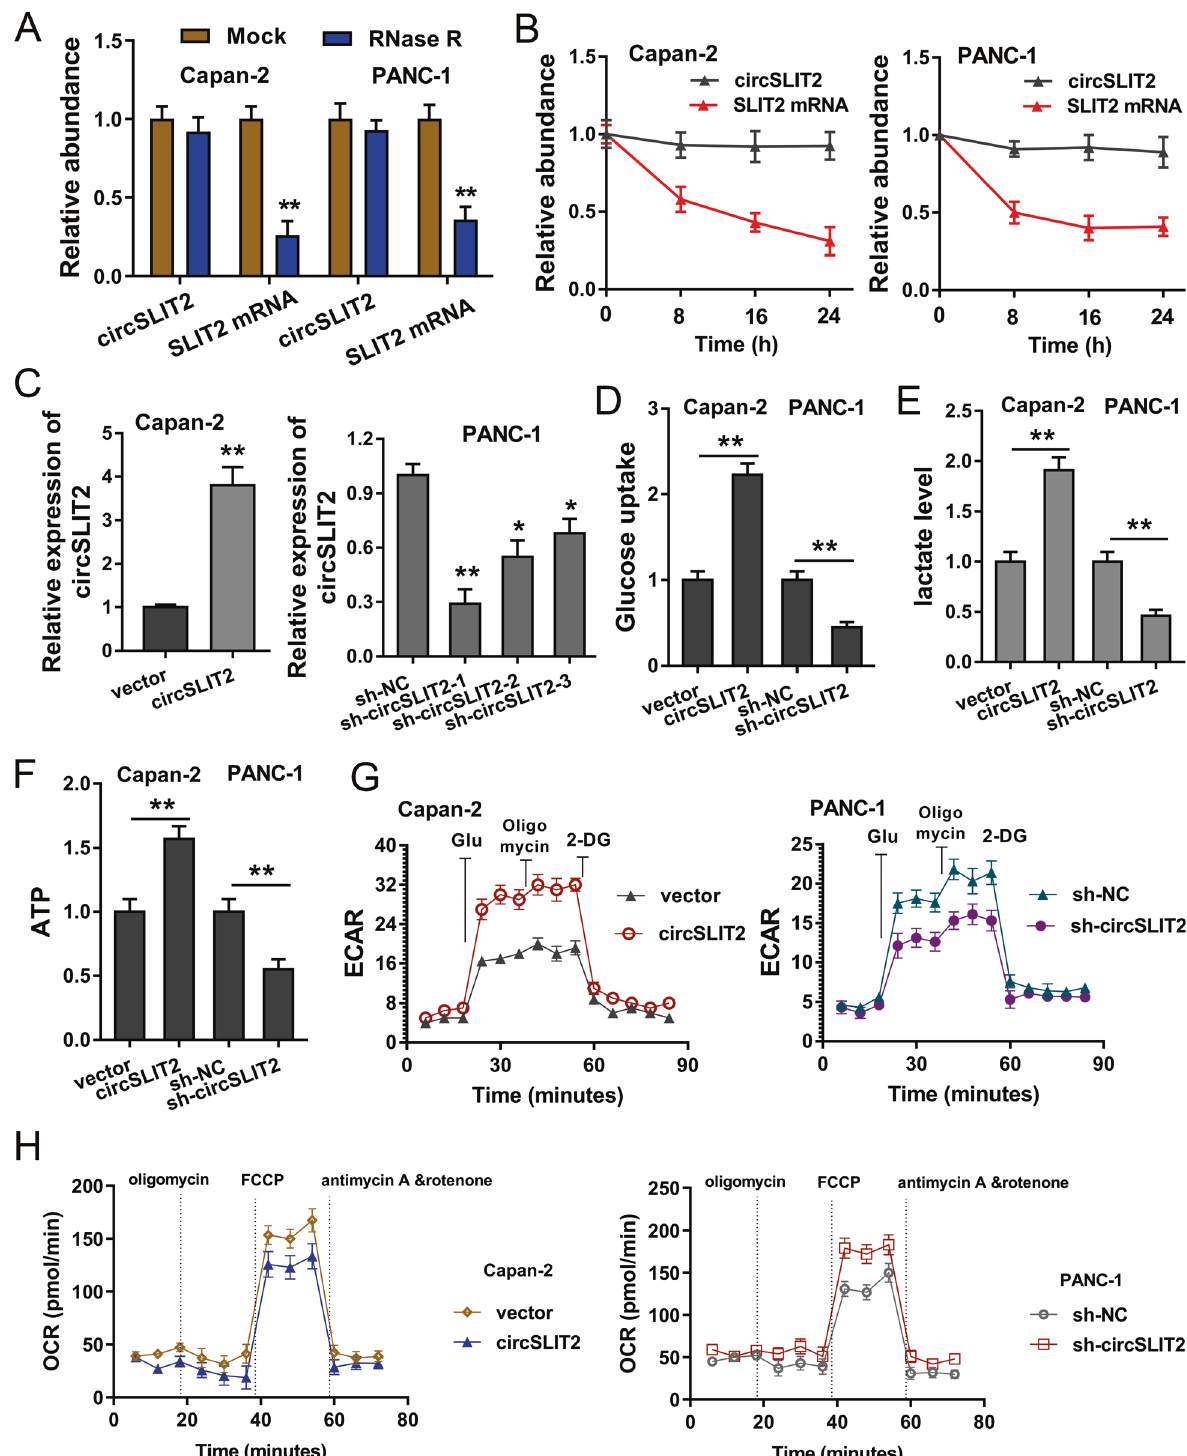
Fig. 2 CircSLIT2 boosted the aerobic glycolysis of PDAC cells. A RT-qPCR showed the expression of circular form transcripts circSLIT2 and linear form transcripts in PDAC cell treated with RNase R. B RT-qPCR indicated the circular form transcripts circSLIT2 and linear form transcripts SLIT2 mRNA in PDAC cells administrated with actinomycin D. C The overexpression and silencing of circSLIT2 transfection were constructed using the plasmids or oligonucleotides transfection in Capan-2 and PANC-1 cells. D The abundance of glucose uptake was measured. E The production quantity measured by lactate analysis in Capan-2 and PANC-1 cells. F ATP analysis indicated the ATP output in PDAC cells. G Extracellular acidi fi cation rate (ECAR) assay and ( H ) oxygen consumption rate (OCR) assay demonstrated the glycolytic capacity of PDAC cells. ** p < 0.01; * p < 0.05.